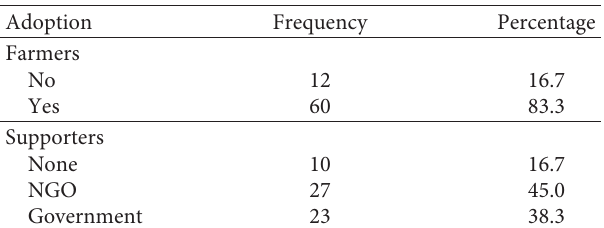
Table 11: Adoption of soil management practices by farmers and their